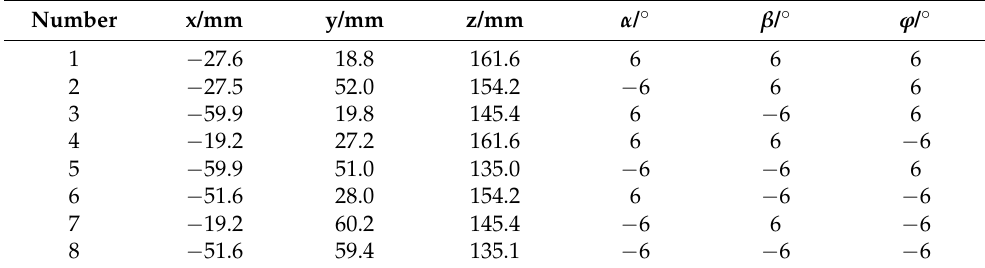
Table 5. The initial coordinates of the center of the passive part mass.